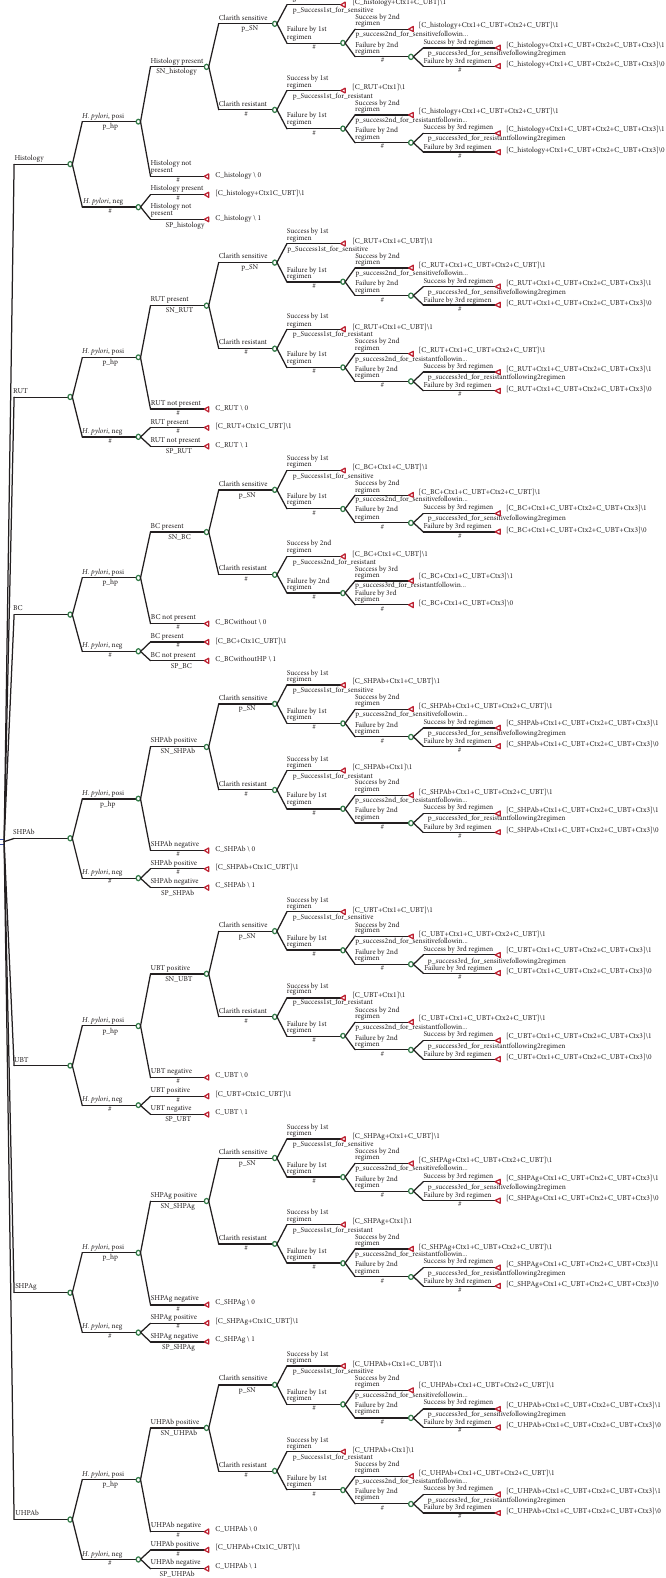
Figure 1: Decision tree. Decision tree was constructed on the assumption that treatment was selected after performing esophagogastroduodenoscopy in all